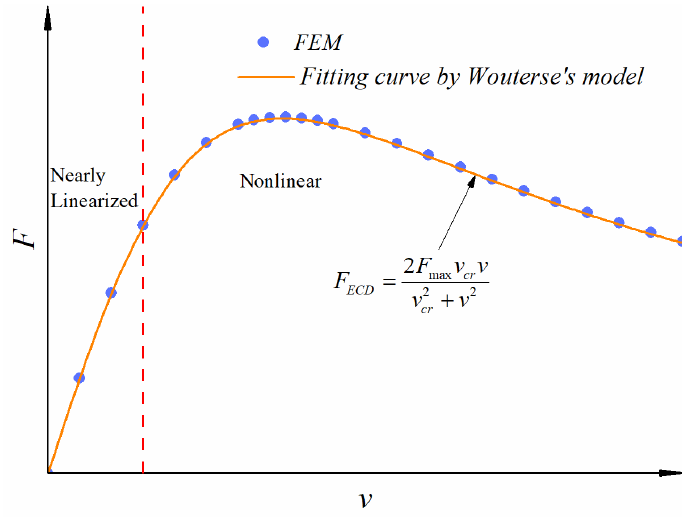
Figure 2. Fitting curve versus FEM results.